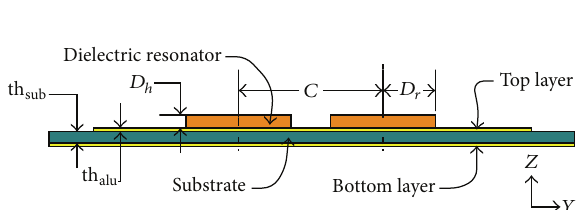
Figure 2: Side view of proposed antenna geometry ( YZ plane), with th sub = 0.22 𝜇 m, th cdr = 300 𝜇 m, 𝐷 ℎ = 0.35 mm, 𝐷 𝑟 = 1.41mm, and 𝐶 = 3.19 mm.